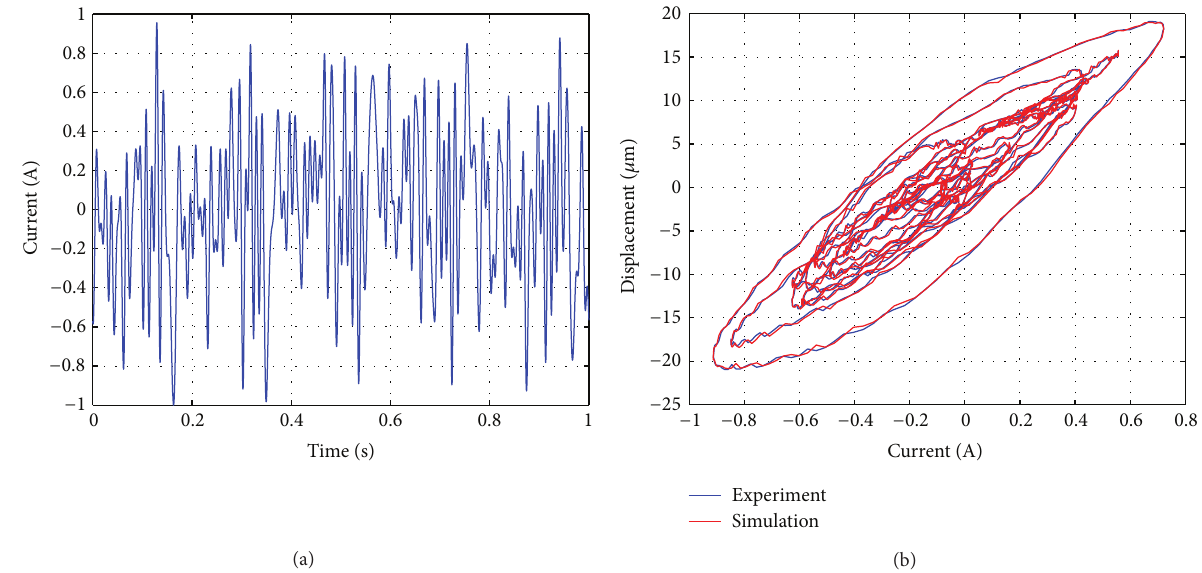
Figure 3: The input signal and the hysteresis loop of the sinusoidal scanning